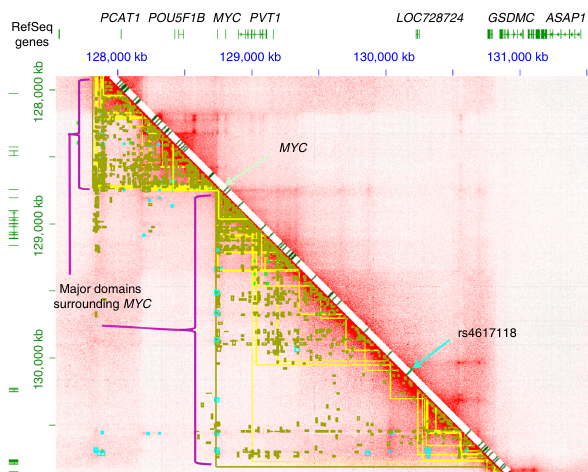
Fig. 3 Chromatin contacts for the 8q24 top hit SNP. Chromosome contacts for lymphoblastoid cell line GM12878 are shown in the region surrounding the SNP. Two large domains to the left and right of the MYC gene are shown (analysis as described by Rao and Huntley 19 ), alongside con fi rmed GWAS catalog alleles for any disease (diagonal line with green hatches indicating previously identi fi ed GWAS SNPs for any indication). Despite the large number of disease associations in this region, there are no known diseases with a GWAS hit at the same location as rs4617118. This SNP is located within the genome domain at the right side of the MYC locus. On the fi gure, distant chromatin contacts are indicated in red color off the diagonal, which is the co-occurrence of sequence using the Hi-C method. The annotations below the diagonal line indicate contact points (yellow lines), the top peaks of contact (cyan, or blue color), and chromatin